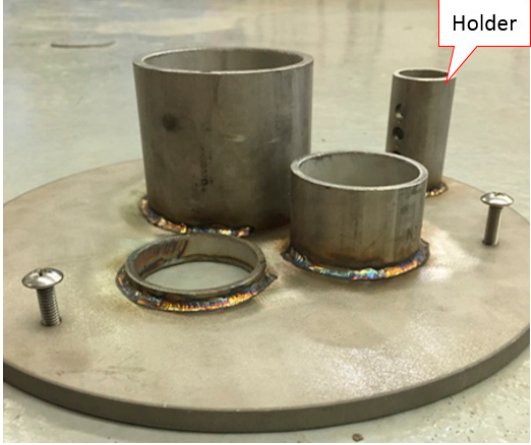
Figure 3. The orifice insert with three vertical pipes and one perforated pressure transducer holder.